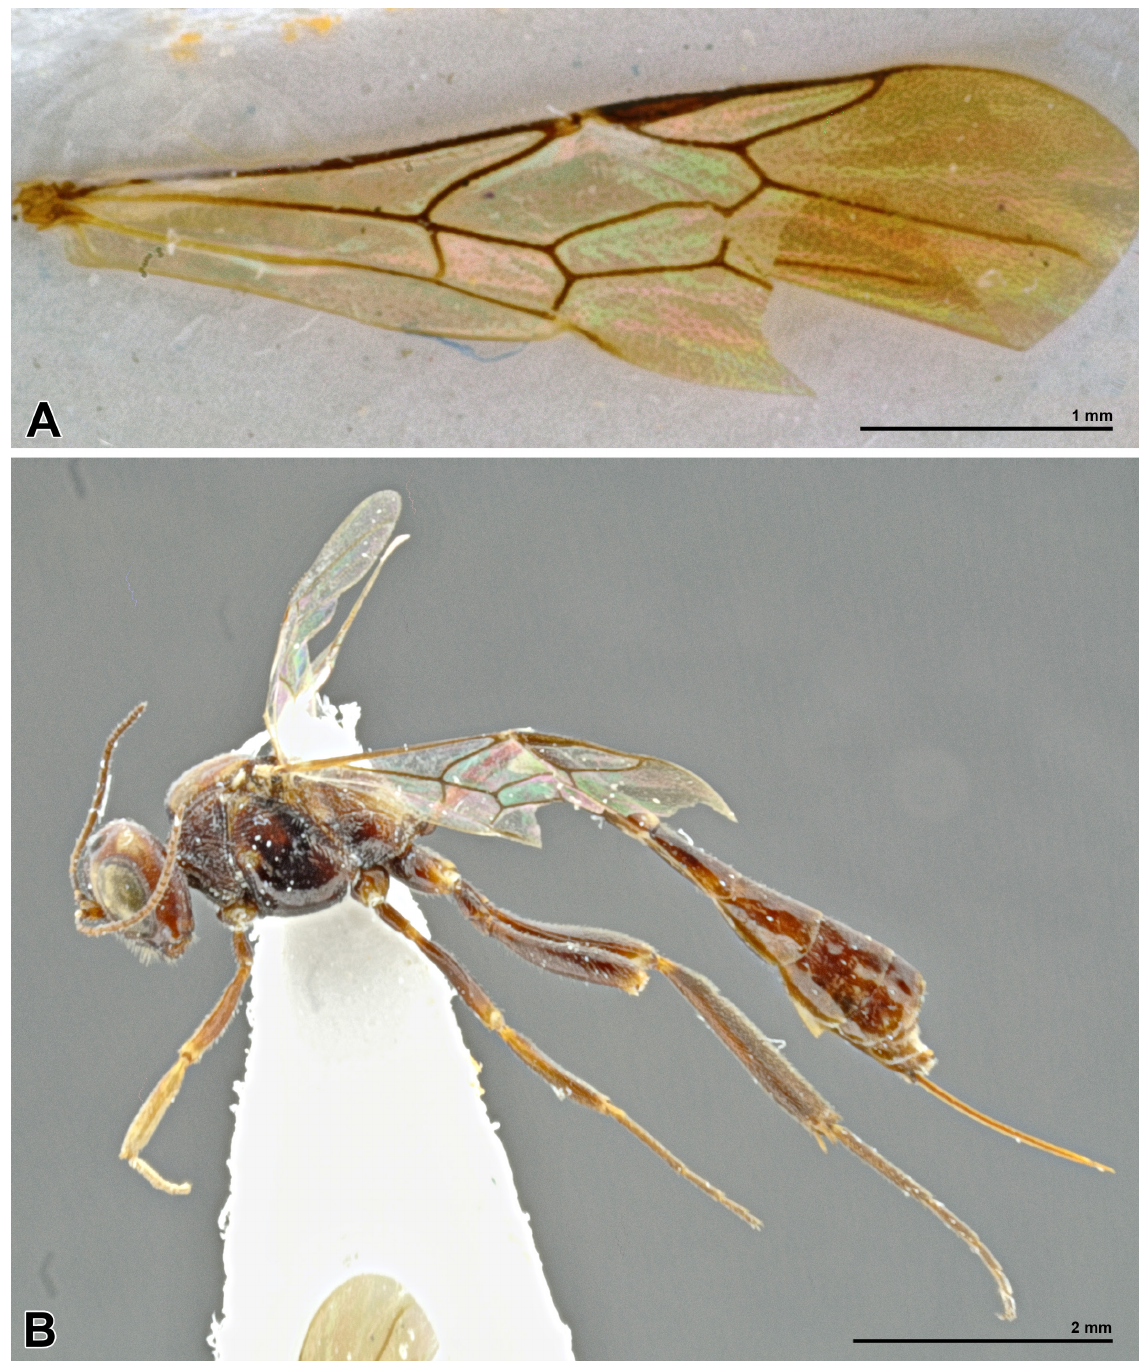
Fig. 3. Anomalon amseli (Hedwig, 1961), ♀, DPPZ. A . Fore wing. B . Habitus, lateral